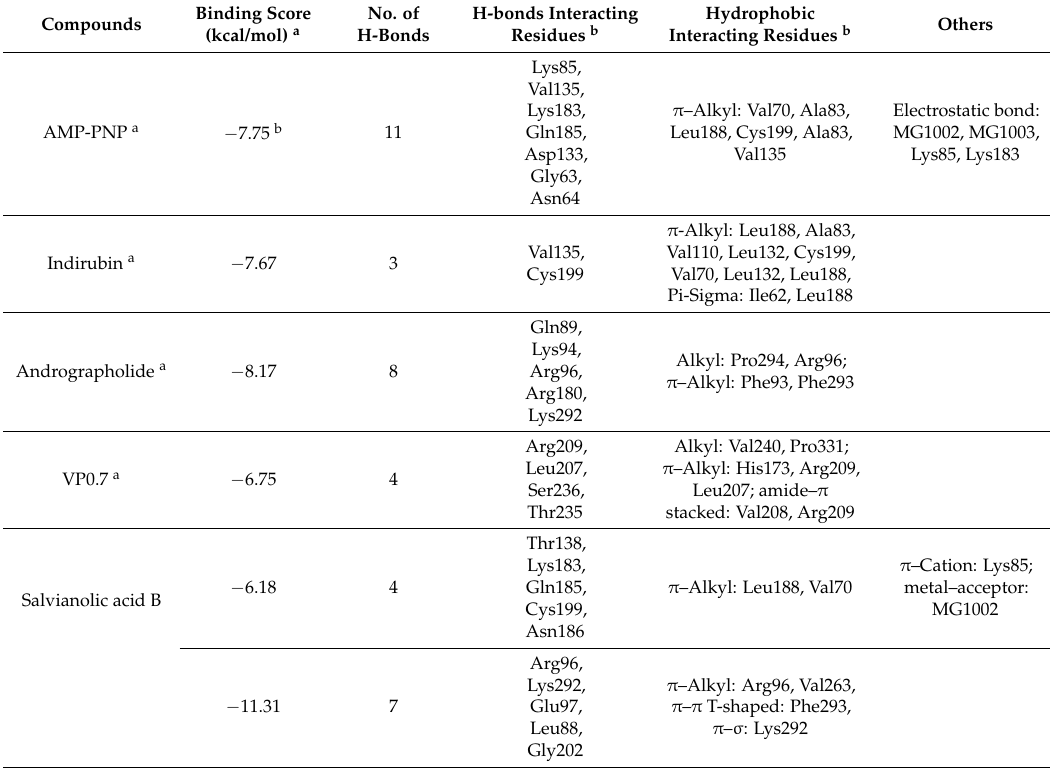
Table 3. Binding sites and docking scores of salvianolic acid B and reference inhibitors in GSK-3 β